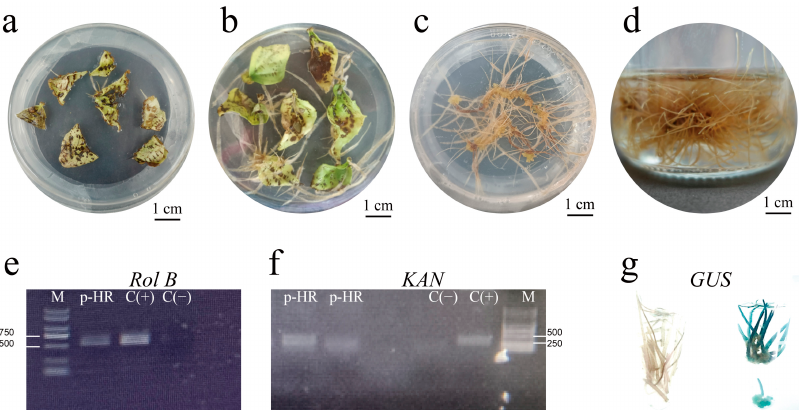
Figure 2. A. rhizogenes Ar Qual strain carrying pCAMBIA 1381Z-mediated hairy root culture. ( a ) Root bulges were formed after the infection of A. rhizogenes Ar Qual strain carrying pCAMBIA 1381Z. ( b ) Hairy roots were formed after the infection of A. rhizogenes Ar Qual strain carrying pCAMBIA 1381Z. ( c ) Solid culture of hairy roots. ( d ) Liquid culture of hairy roots. ( e ) PCR analysis of the Rol B gene in the hairy root line of T. hemsleyanum [lane M, marker; Lp-HR, the hairy roots lines induced by A. rhizogenes Ar Qual strain carrying pCAMBIA 1381Z; C(+), plasmid DNA from A. rhizogenes Ar Qual strain carrying pCAMBIA 1381Z (positive control); C( − ), roots from a non-transformed control plant (negative control)]. ( f ) PCR analysis of the KAN gene in the hairy root lines of T. hemsleyanum [lane M, marker; Lp-HR, the hairy roots lines induced by A. rhizogenes Ar Qual strain carrying pCAMBIA 1381Z; C(+), plasmid DNA from A. rhizogenes Ar Qual strain carrying pCAMBIA 1381Z (positive control); C( − ), roots from a non-transformed control plant (negative control)]. ( g ) GUS staining in hairy roots. HR, the hairy root lines induced by A. rhizogenes Ar Qual-wild type strain; p-HR, the hairy root lines induced by A. rhizogenes Ar Qual strain carrying pCAMBIA 1381Z.